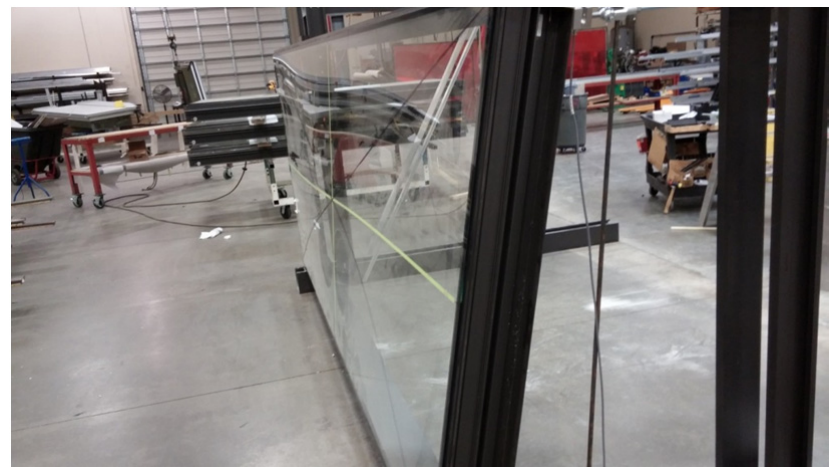
Fig. 5 Photo of Buckled Glass from Previous Testing by